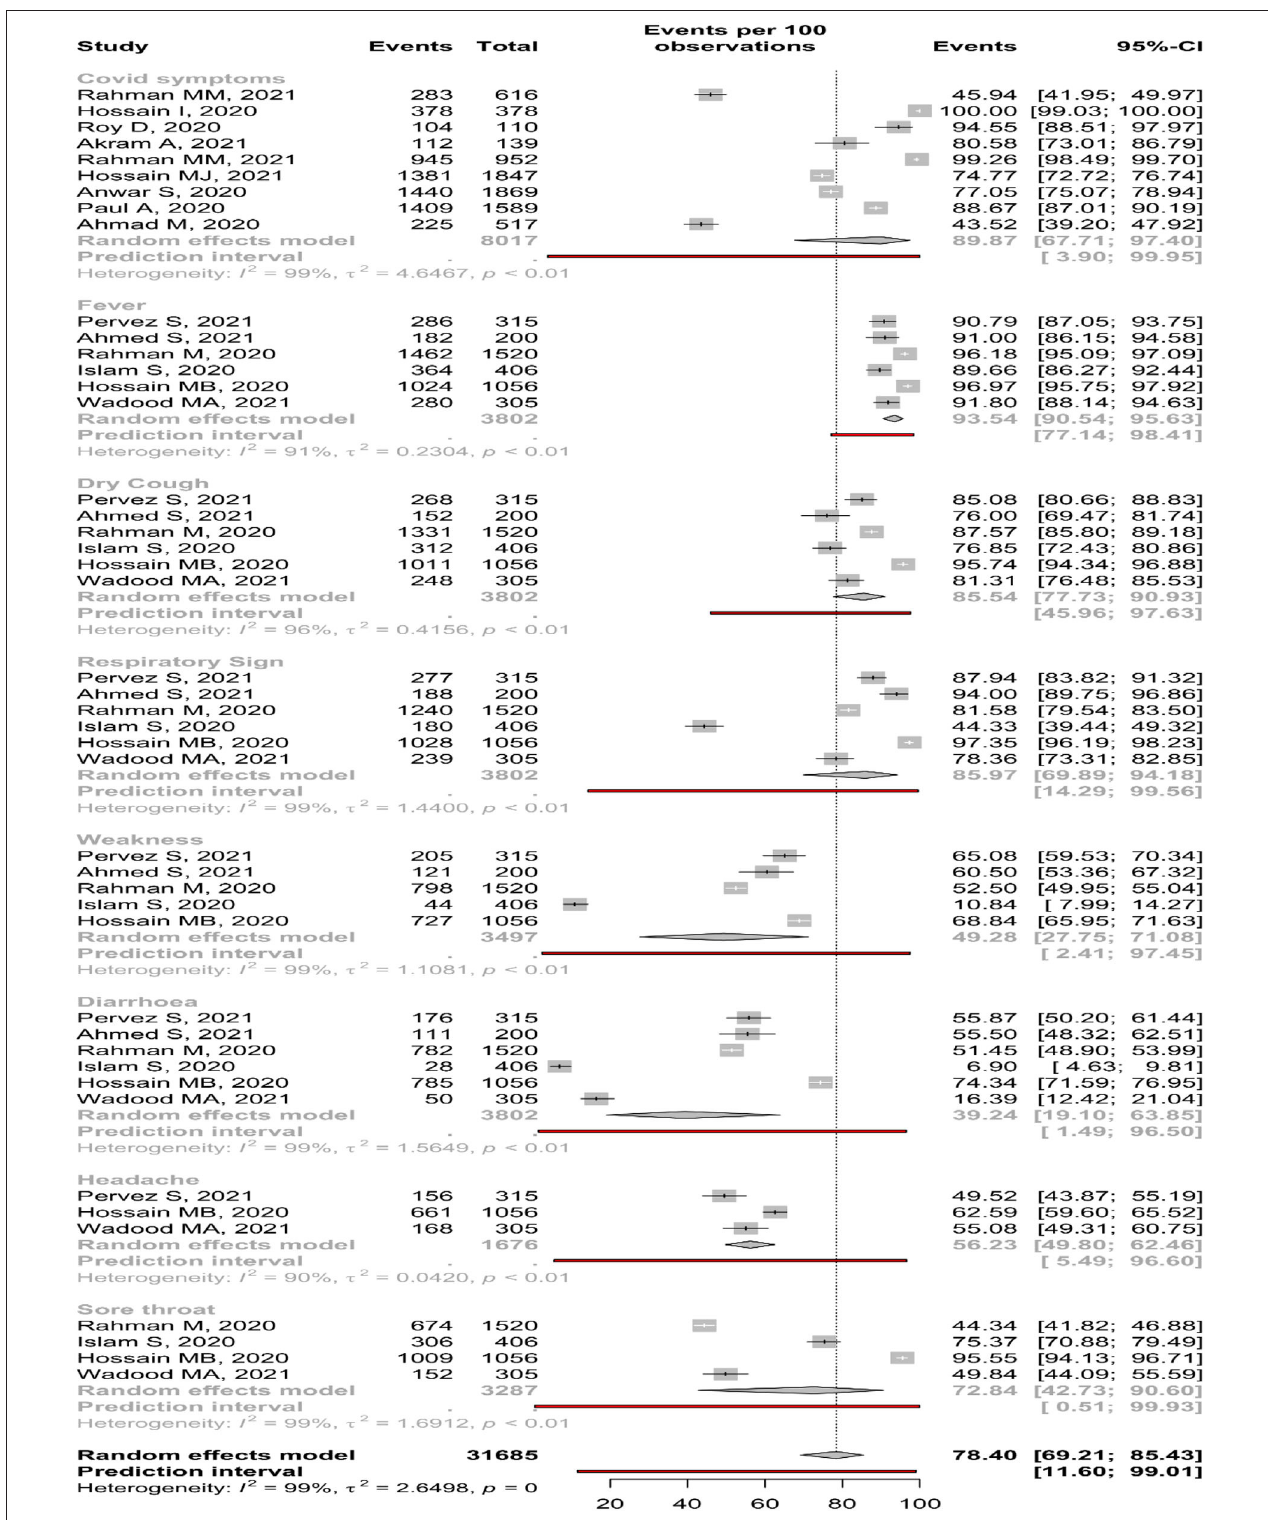
FIGURE 2 | Knowledge about COVID-19 symptoms among Bangladeshi residents.